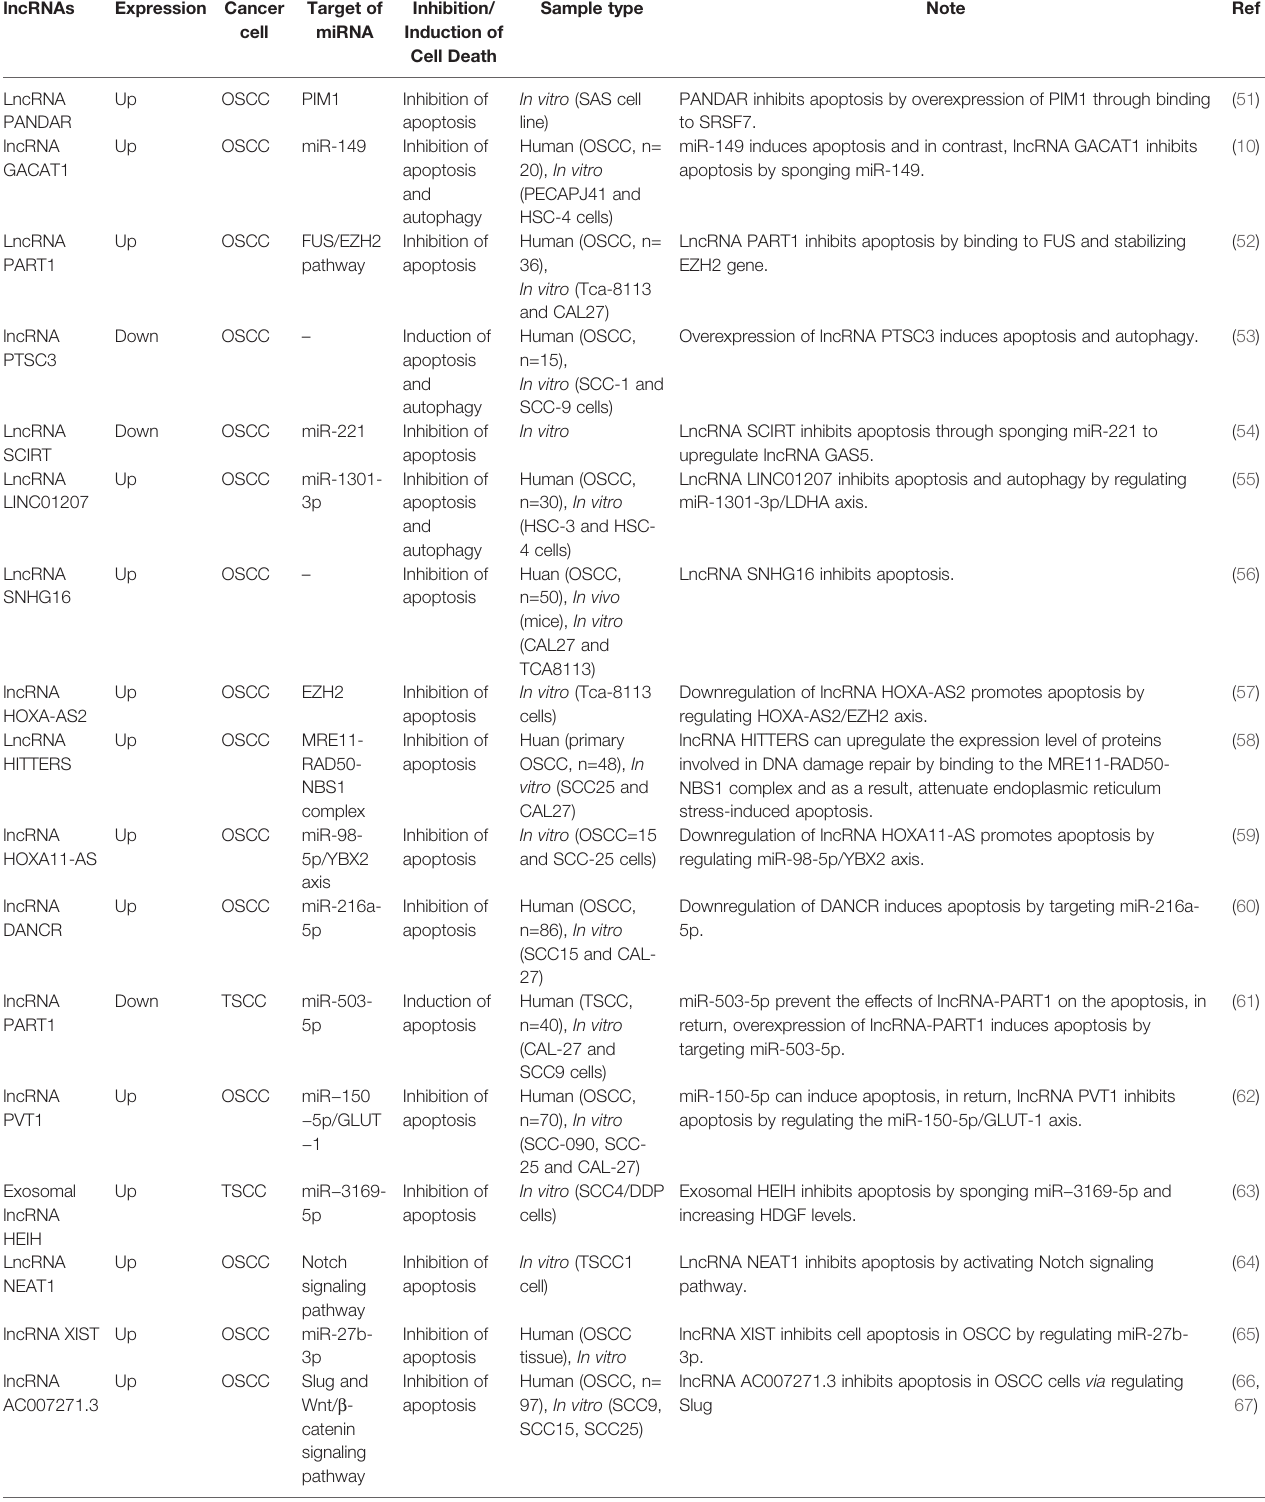
TABLE 4 | lncRNAs can regulate cell death pathways in oral cancer.